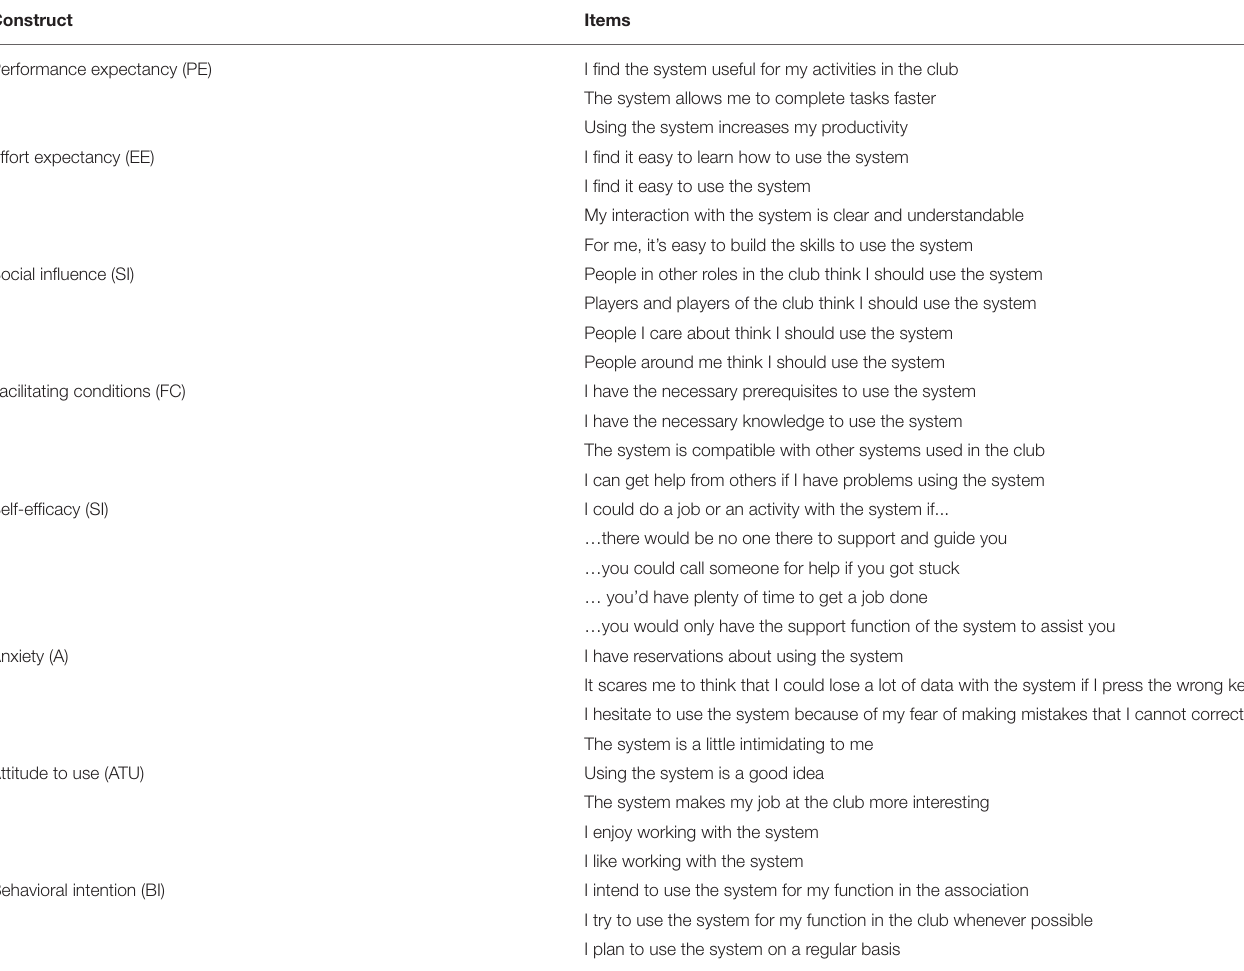
TABLE 1 | Representation of the queried items per construct. Construct